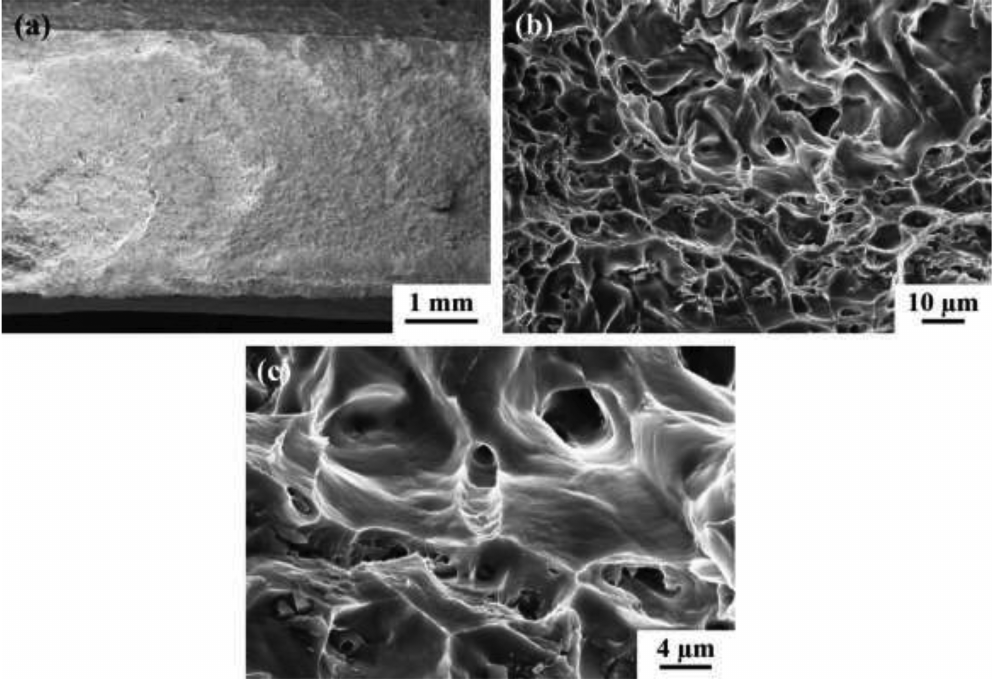
Figure 11: Fracture morphologies of a DWMW joint after tensile testing: (a) general view; (b) the ductile fracture appearance and (c) details of the ductile fracture